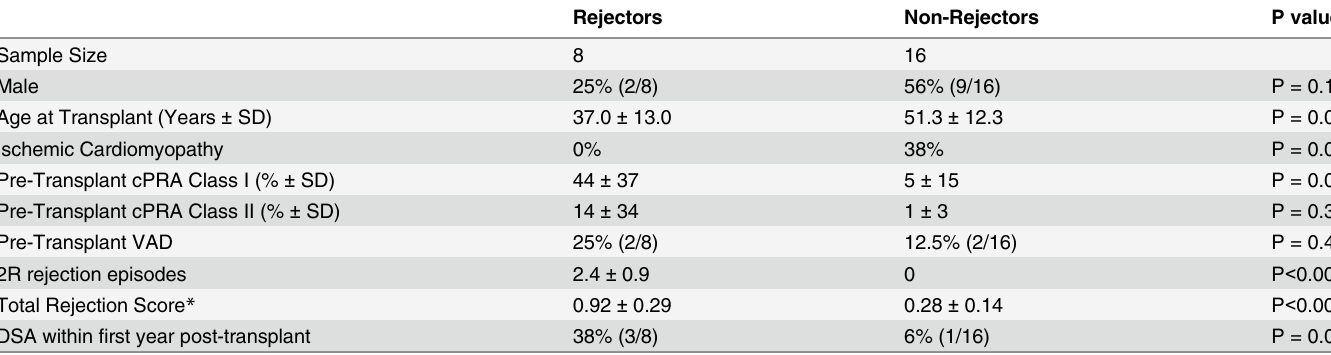
Table 2. Pre-Transplant Study: Comparison of rejector and non-rejector patient